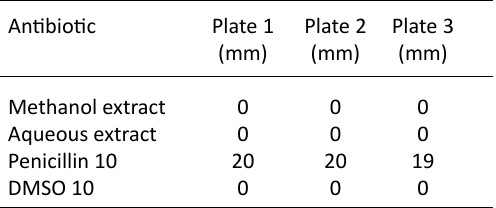
Table 3. P-value of the extract against Staphylococcus aureus